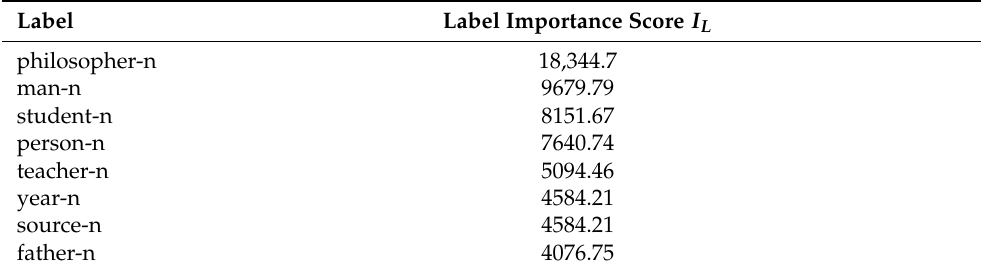
Table 3. Label candidates for community FoF [ and | or ] ethics